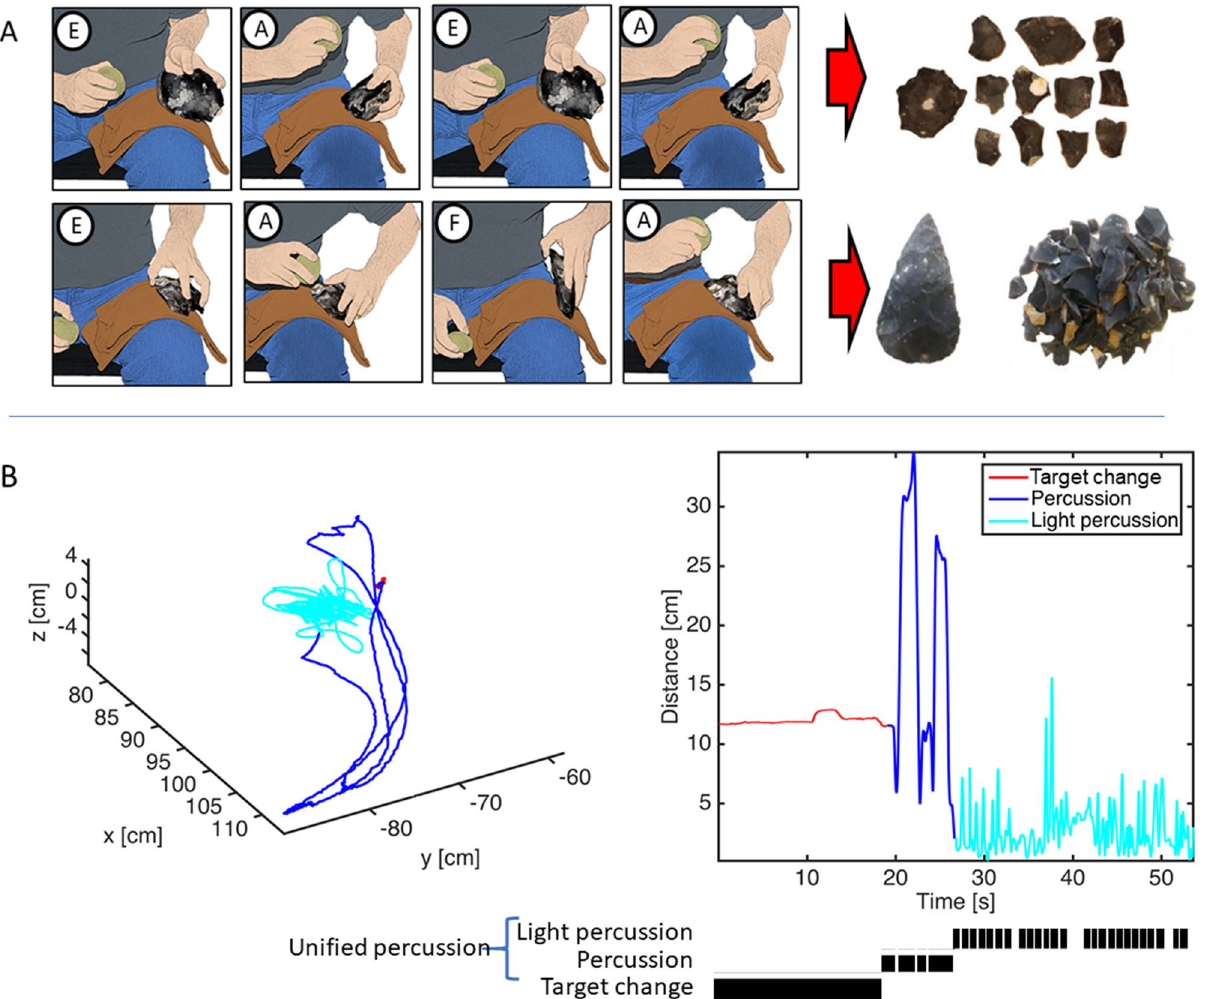
Figure 1. Symbolic Modeling of tool-making action sequences. ( A ) Oldowan (top) and Acheulean (bottom) action sequences were coded using 7 event codes (circled letters, see Materials & Methods). Products illustrated to the right, individual depicted is the first author. ( B , Left) Spatial trajectory of the hammer stone during toolmaking. The X–Y plane is aligned with the plane of the percussion strike hand-arm movements. The core is centred at approximately 80 cm, − 70 cm, 0 cm. ( B , Right) Distance of the hammerstone from the centre of the core. Target change movements are coded in red. Percussion strike trajectories are in dark blue, light percussion movements (here for platform preparation) are in light blue. Below, the black bars indicate the corresponding timing and duration of the